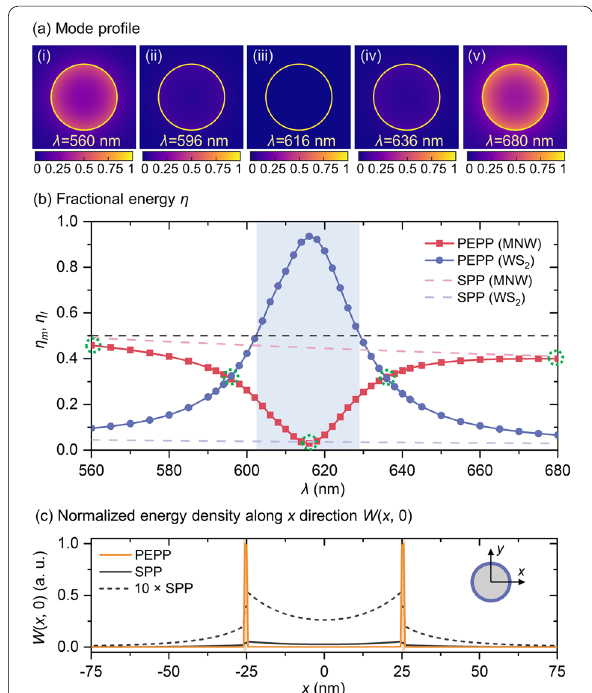
Fig. 3 Mode characteristics and evolution with wavelengths ( λ ) of the PEPP. a Mode profiles in terms of energy density distributions, showing the mode transition between SPP-like and exciton-like characters, ( i – v ) λ 560, 596, 616, 636, and 680 nm, respectively. b = Quantitative characterization in terms of fractional energy inside the MNW ( η m ) and the WS 2 layer ( η l ). η m and η l for PEPP (SPP) are denoted by squared red and dot blue lines (red and blue dashed lines), respectively. For the SPP, η l is calculated by setting oscillator strength of the WS 2 cladding to be zero. For the PEPP, black dashed line indicates η l 0.5, and blue-filling area indicates the exciton-like = region. Green circles: η m for PEPPs at the wavelengths of 560, 596, 616, 636, and 680 nm shown in a . Their corresponding η m are ~ 0.46 a ( i ), ~ 0.32 a ( ii ), ~ 0.03 a ( iii ), ~ 0.32 a ( iv ), and ~ 0.40 a ( v ), respectively. c Normalized energy density along x direction W ( x , 0) at λ 616 nm. = Yellow line: PEPP. Gray solid and dashed lines: SPP and its 10 times multiplication for clear visualization. Inset: coordinates on the cross section. The diameter for the Ag MNW here is 50